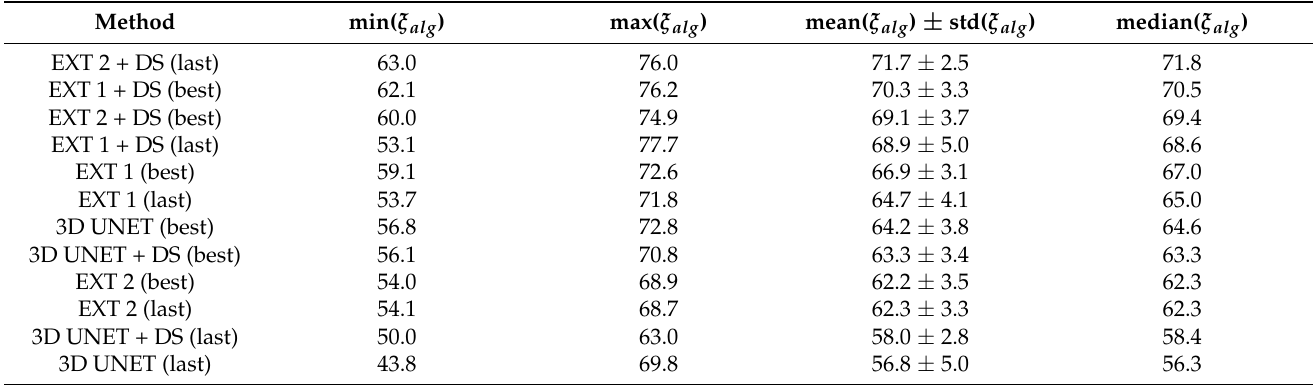
Table 5. Effectiveness of the proposed ovary detection methods trained and evaluated 50 times on the USOVA3D database. The minimum, maximum, mean and median of the overall algorithm’s score are presented over 50 runs. Entries are sorted with respect to the median